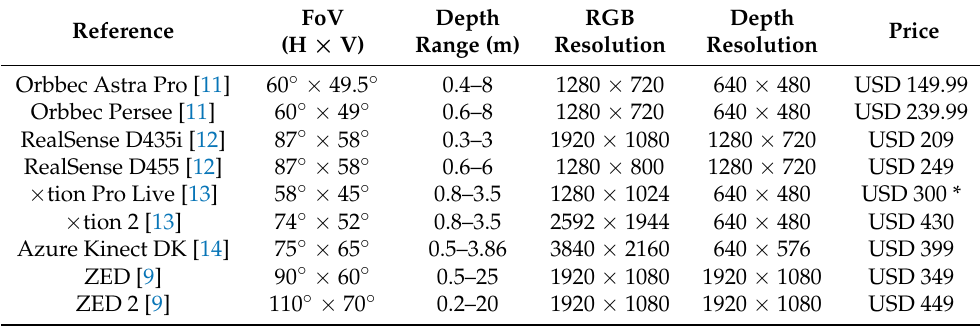
Table 1. The relevant characteristics of cameras used in service robots. RGB and depth resolution working at 30 fps. FoV values correspond to the depth image. The Intel D435i and D455 include an IMU. Elements with (*) are currently